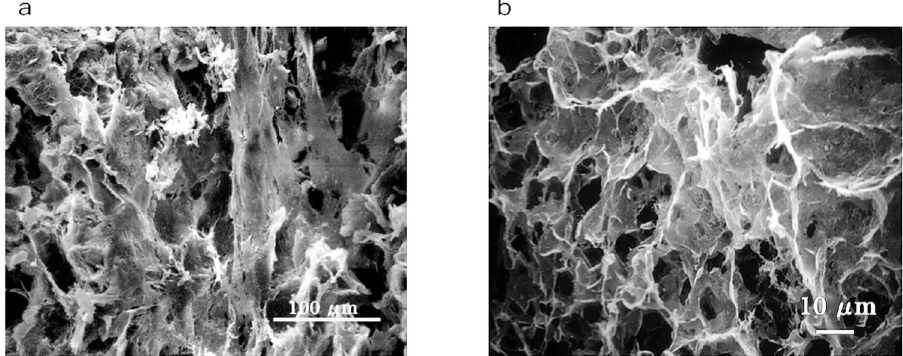
Fig 3. Scanning electron microscope images of mammoth soft tissues. (a) Liver section from Masha. (b) Lung section from